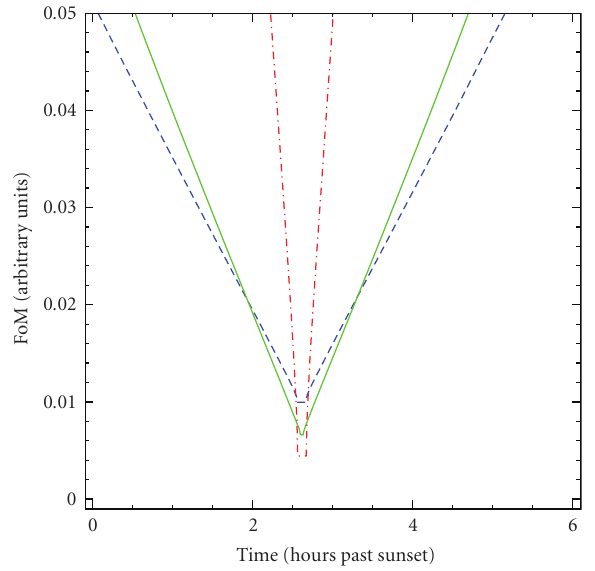
Figure 3: Scheduler FoM for objects with the same priority = 1, RA = 15 h and δ = +10, +30, and +60 for red dot-dashed, green solid and blue long dashed line,